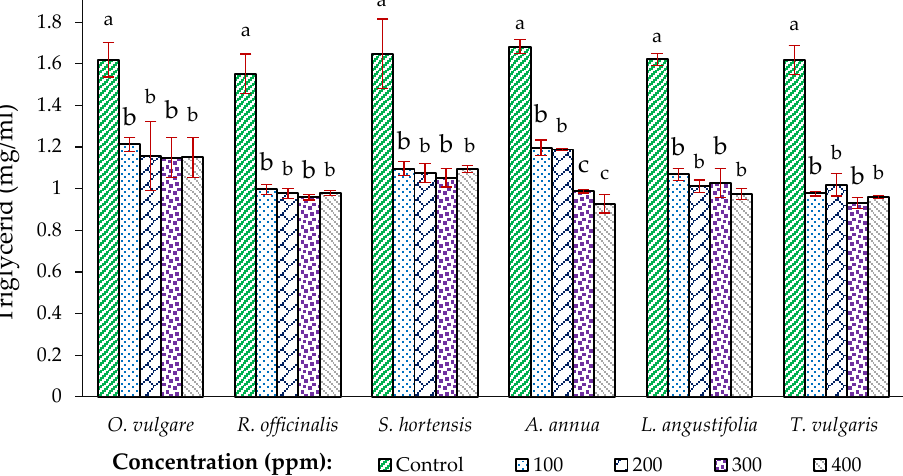
Figure 4. Effect of different concentrations of essential oils on total triglyceride (mg/mL) of Xanthogaleruca luteola eggs. Statistical differences are shown by different letters according to Tukey’s test at p ≤ 0.05.